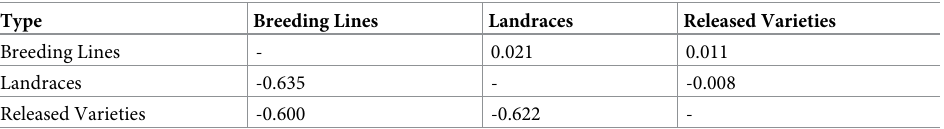
Table 10. Population pair wise F sts between populations of common bean genotypes. Type Breeding Lines Landraces Released Varieties Breeding Lines - 0.021 0.011 Landraces -0.635 - -0.008 Released Varieties -0.600